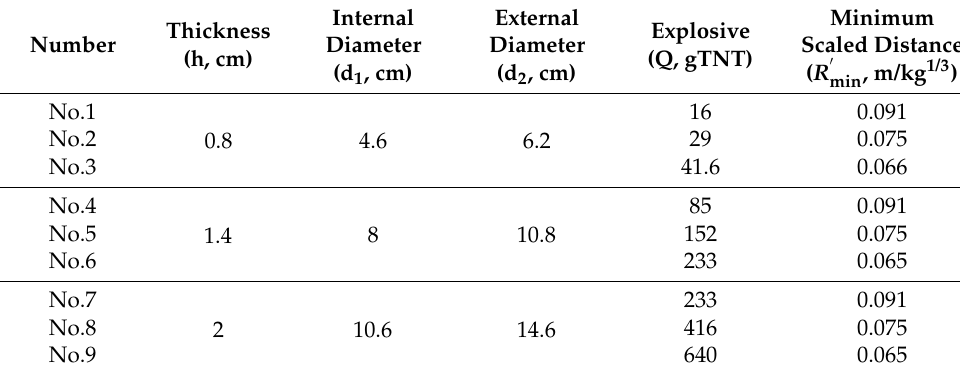
Table 1. The arrangement of each experiment.